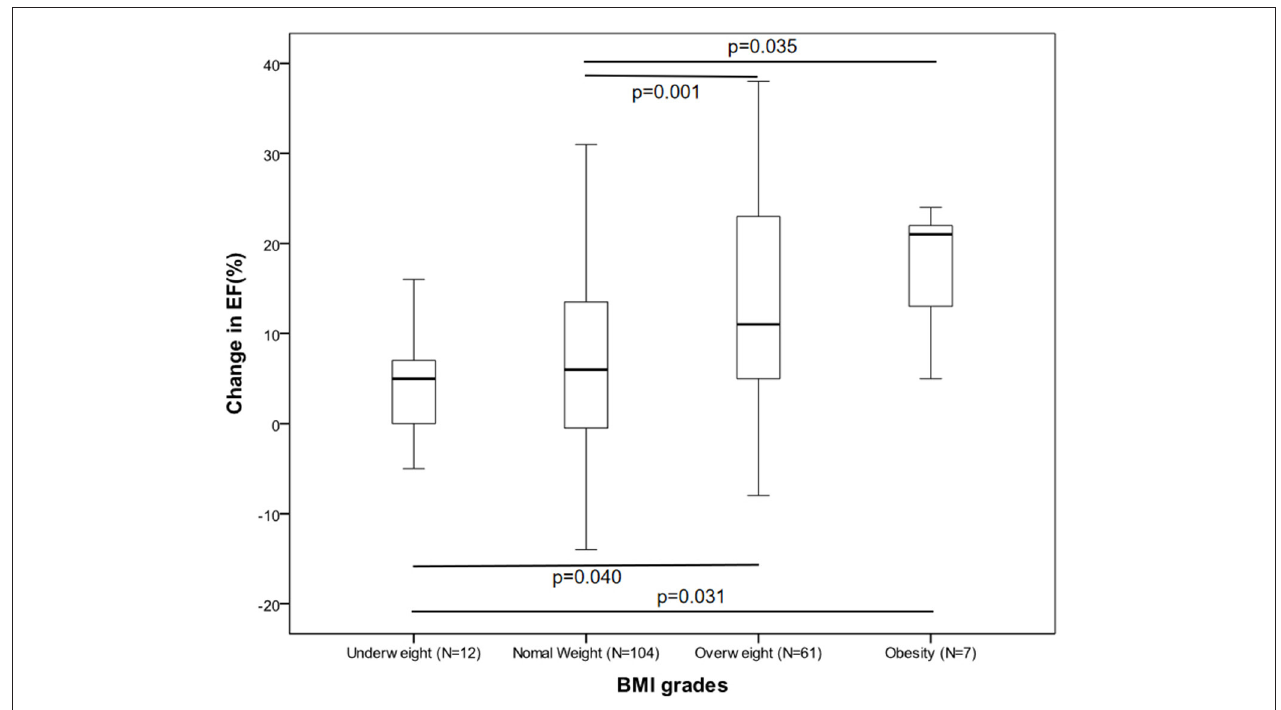
FIGURE 1 | Box plot comparing change in ejection fraction by BMI group.